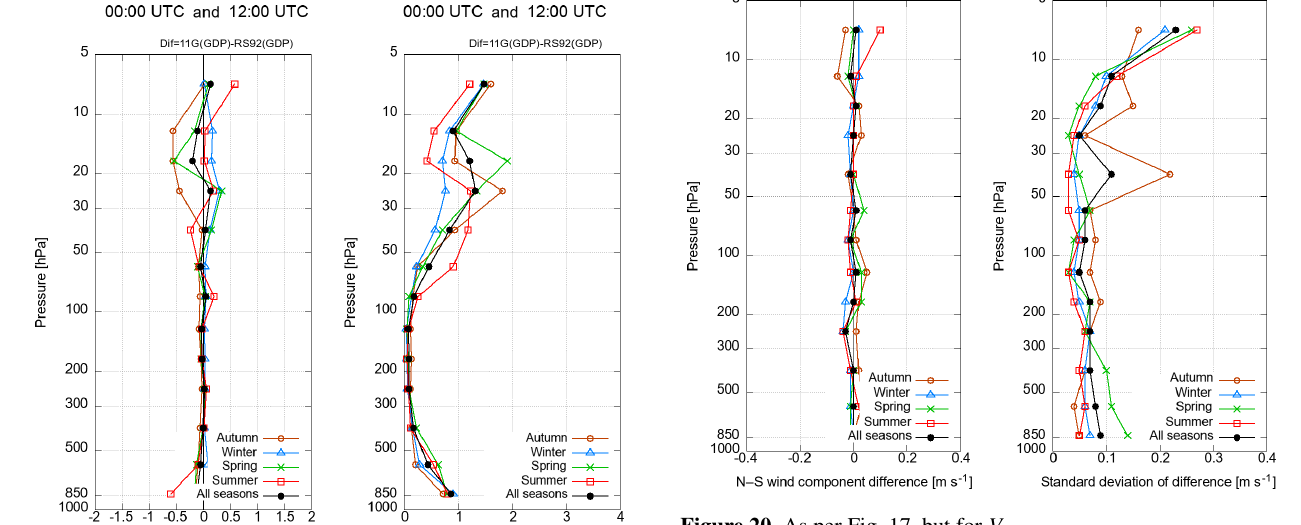
Figure 20. As per Fig. 17, but for V